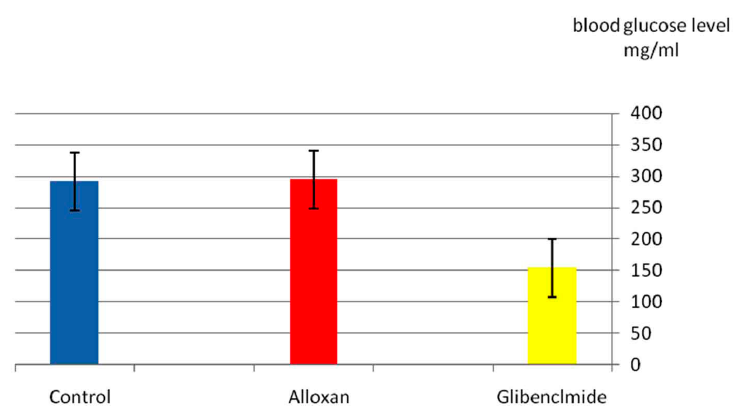
Fig. 3. Effect of glibenclamide drug in blood glucose level of laboratory rats after 3hrs of treatment